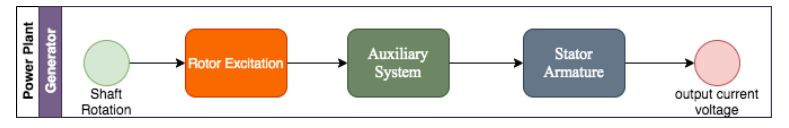
Figure 3. Generator